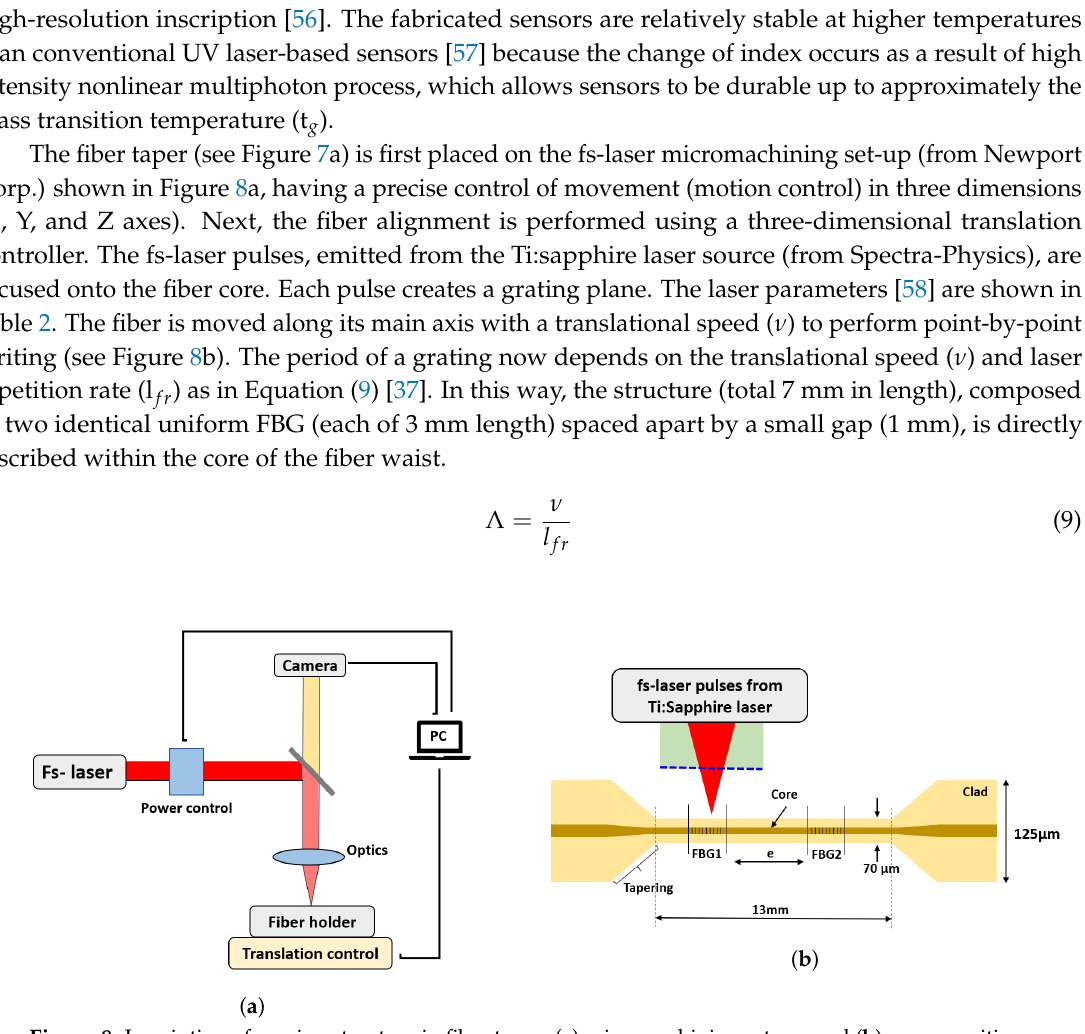
Figure 8. Inscription of sensing structure in fiber taper: ( a ) micromachining set-up; and ( b ) sensor